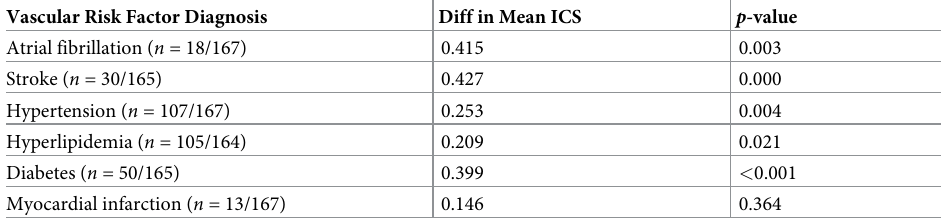
Table 3. ICS associates with vascular risk factor diagnoses.